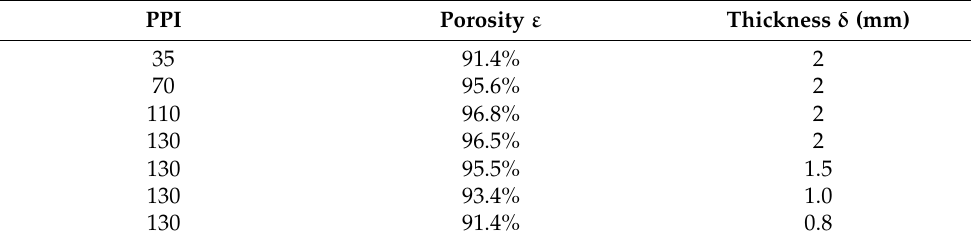
Table 1. Copper foam sample